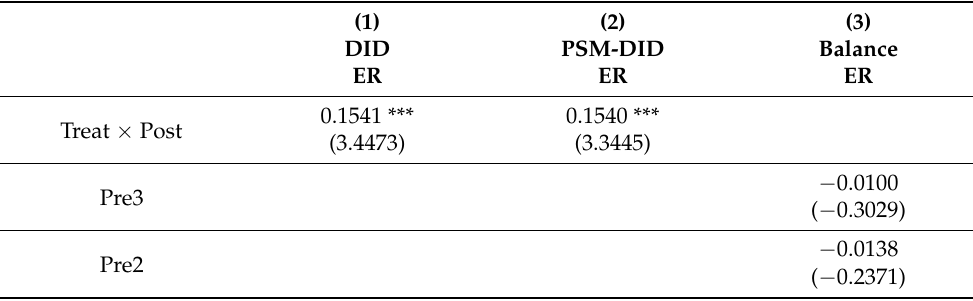
Table 5. DID regression